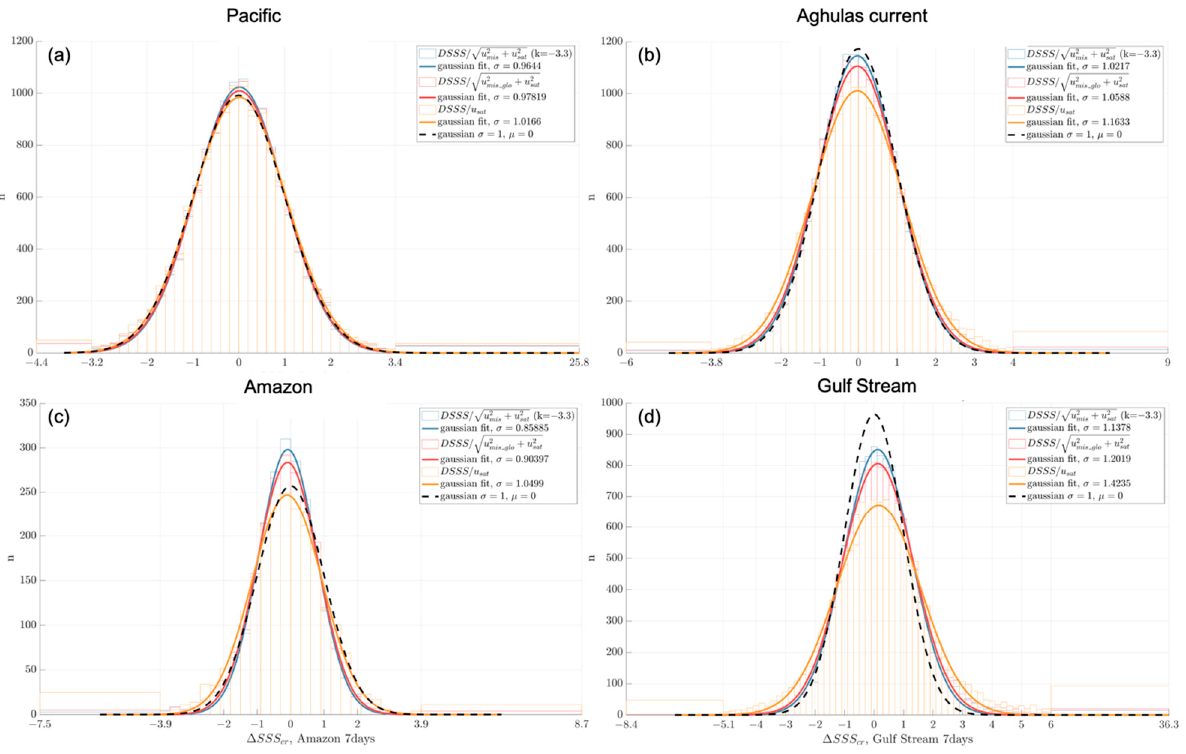
Figure 5. Same as Figure 4 for regions defined on Table 1: ( a ) Pacific; ( b ) Aghulas Current; ( c ) Amazon; ( d ) Gulf Stream. Corresponding STD are reported in Table 2. Table 2. STD of the distributions of the normalized differences between Argo and CCI v3.2 weekly products, in the regions defined in Table 1.